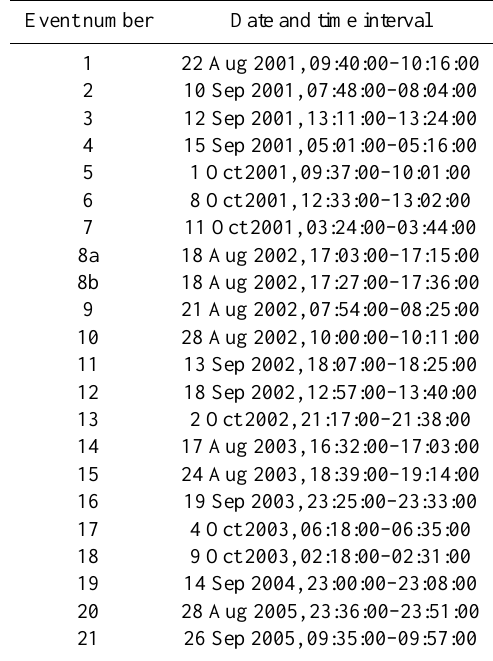
Table 1. Ion diffusion region encounters by the Cluster